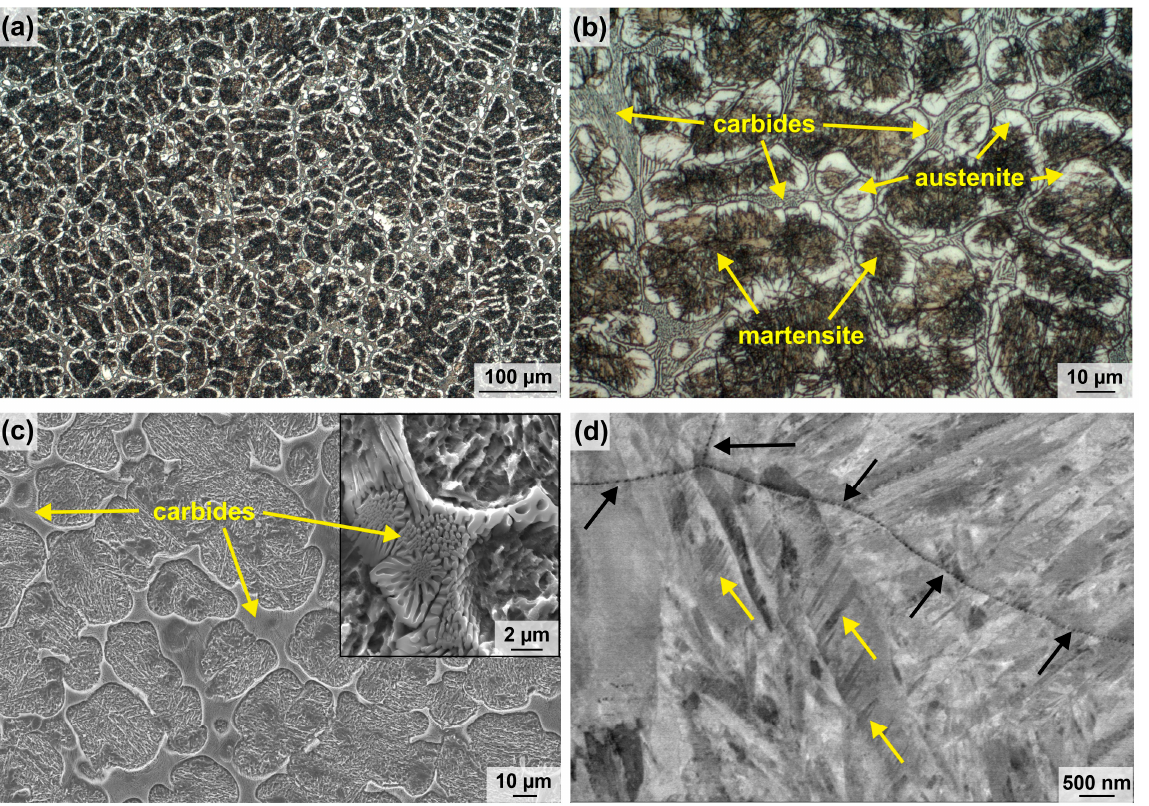
Figure 2. Microstructure of the novel Fe81Cr15V3C1 steel: ( a , b ) OM images of the surface after etching with Beraha I, ( c ) SEM images (SE contrast) of deep-etched samples revealing interdendritic carbide morphologies (inset) and their distribution as well as ( d ) SEM image (BSE contrast) of trails of nanocarbides (black arrows) and twinned martensite (yellow arrows).